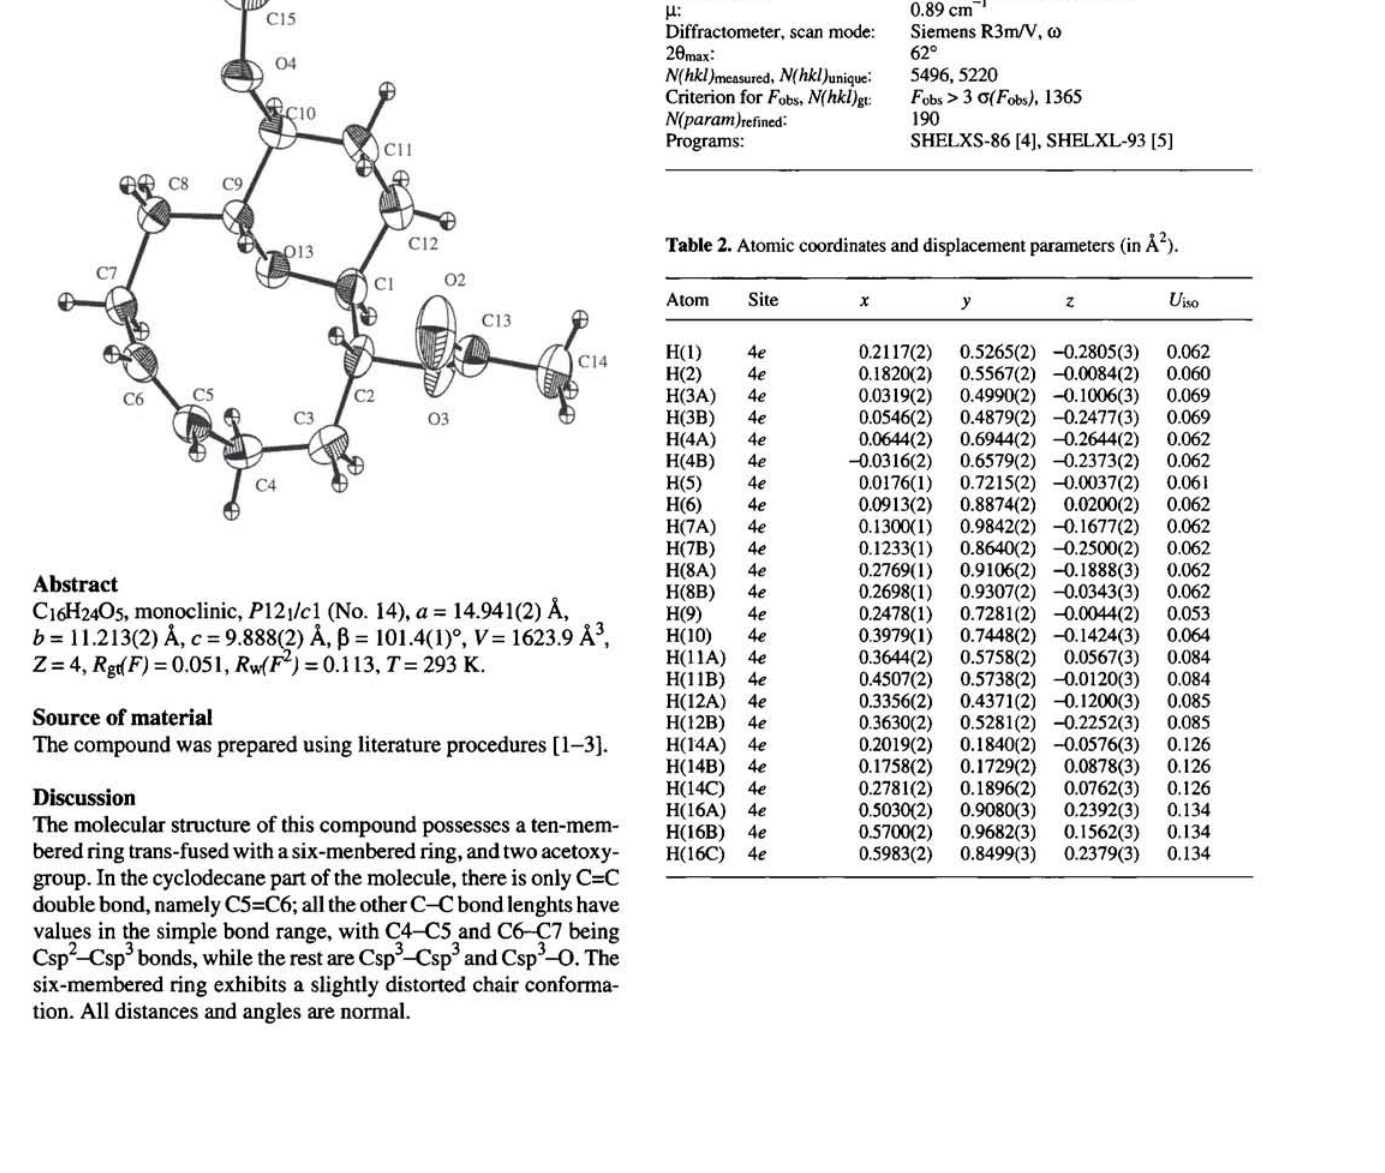
Table 1. Data collection and handling.